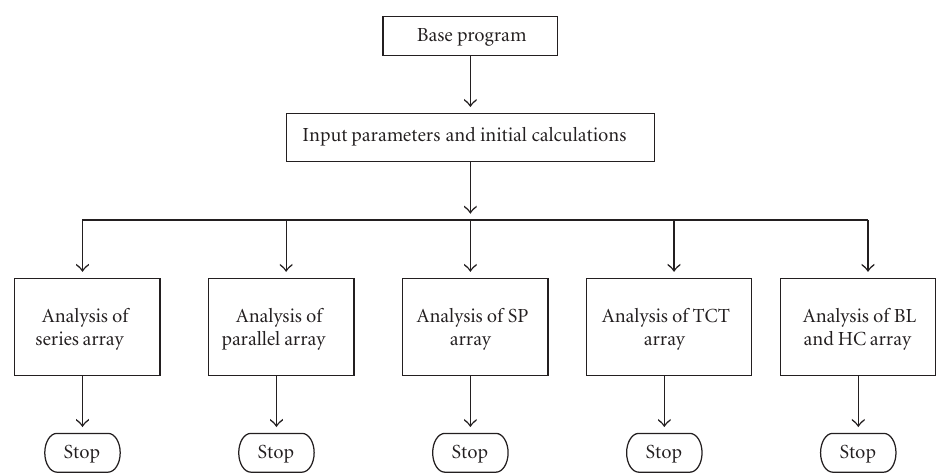
Figure 3: Illustration of 6 × 4 array with a particular shading pattern.